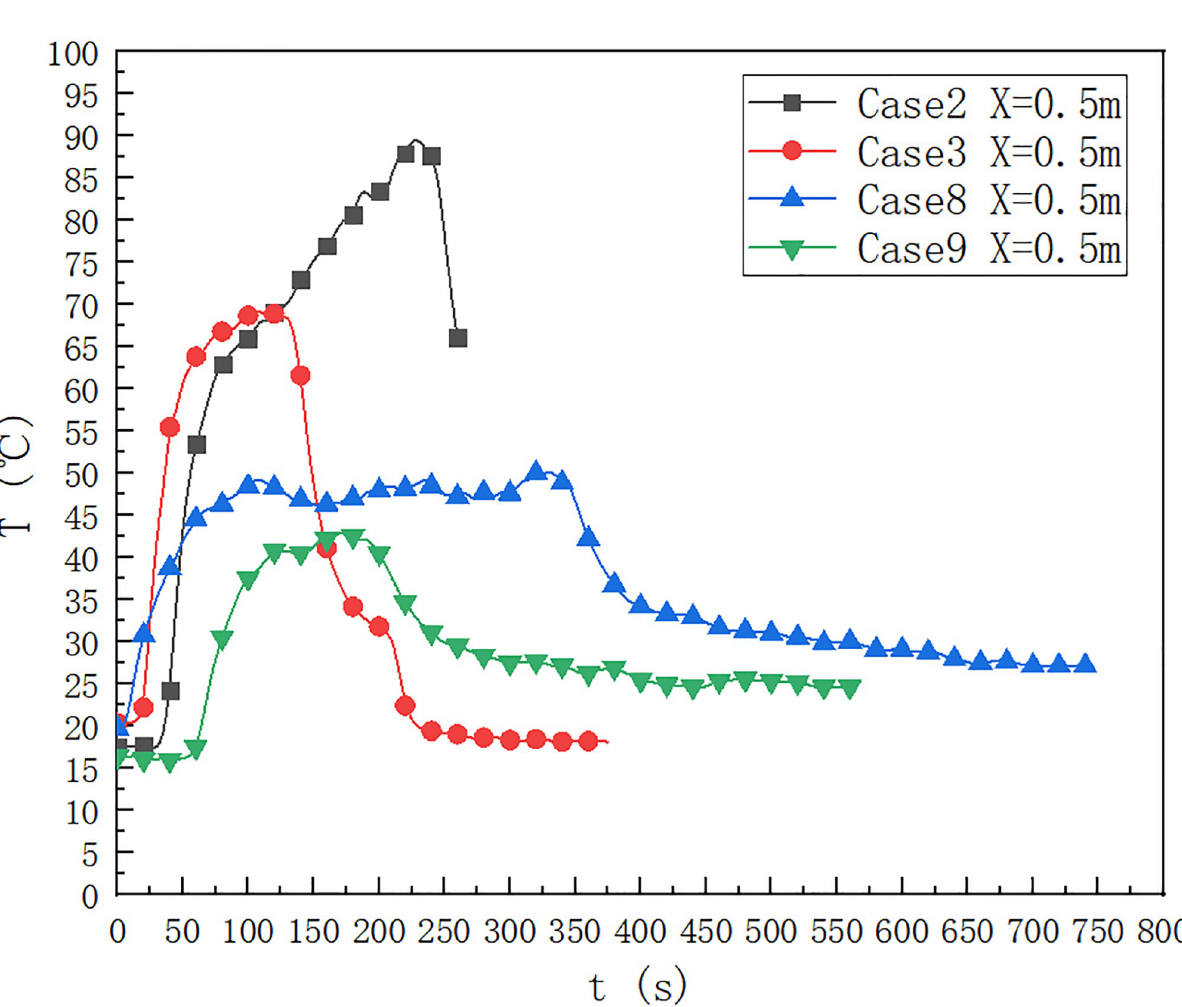
Fig 9. Temperature change below the ceiling of the cable compartment in the utility tunnel at 2,3,8 and 9 at a distance of 0.5 m from the fire